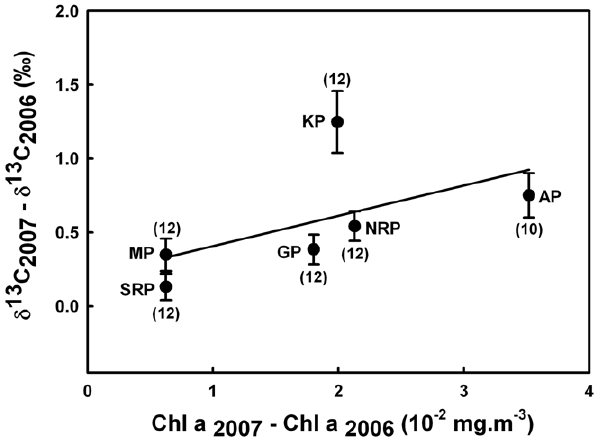
Figure 2. Correlation between inter-annual differences in penguin feather d 13 C values and in sea-surface Chl a (corre- sponding years). Values are mean 6 SE. Numbers in parentheses indicate sample sizes (N=70). Solid line represents the linear regression (y=20.87x + 0.20, r =0.354 and p =0.003). Abbreviations: AP, Ade´lie penguin; GP, gentoo penguin; KP, king penguin; MP, macaroni penguin; NRP and SRP, northern and southern rockhopper penguins,